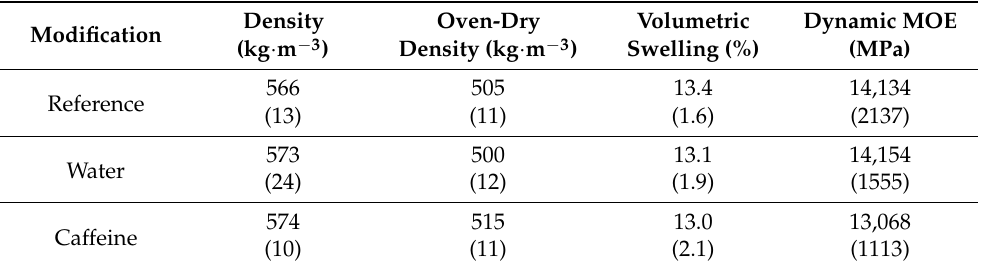
Table 2. Basic statistical analyses, mean value (standard deviation) of the selected properties for pine wood.